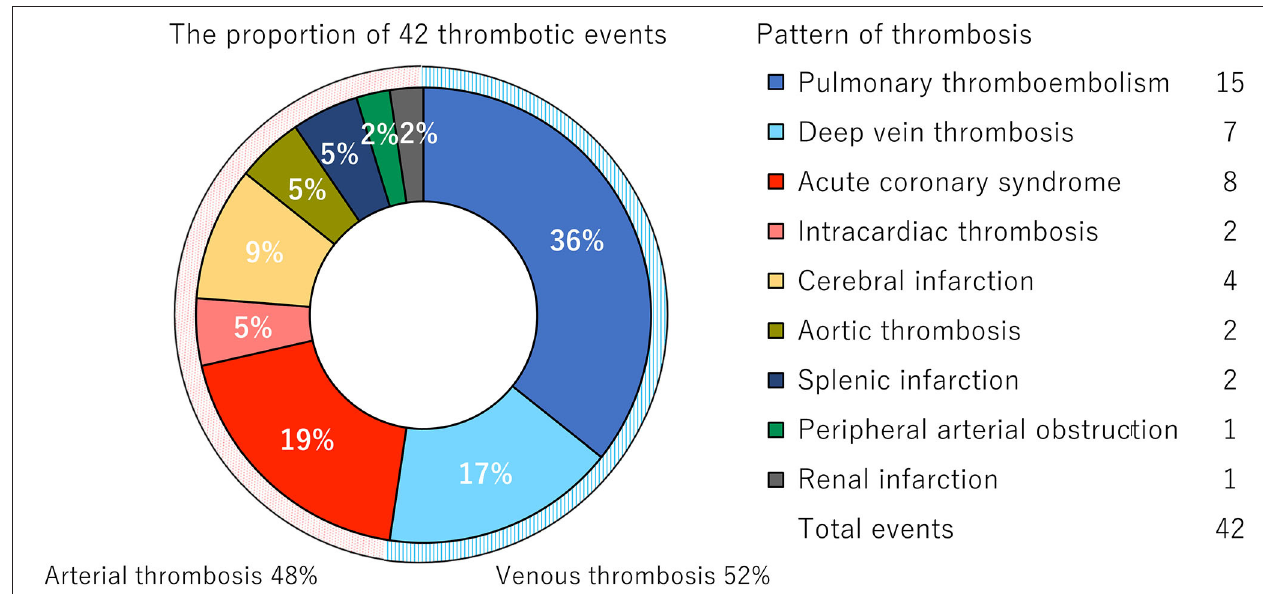
FIGURE 1 | Distribution of the thrombotic events. Pie chart represents the proportion of 42 thrombotic events complicated in 32